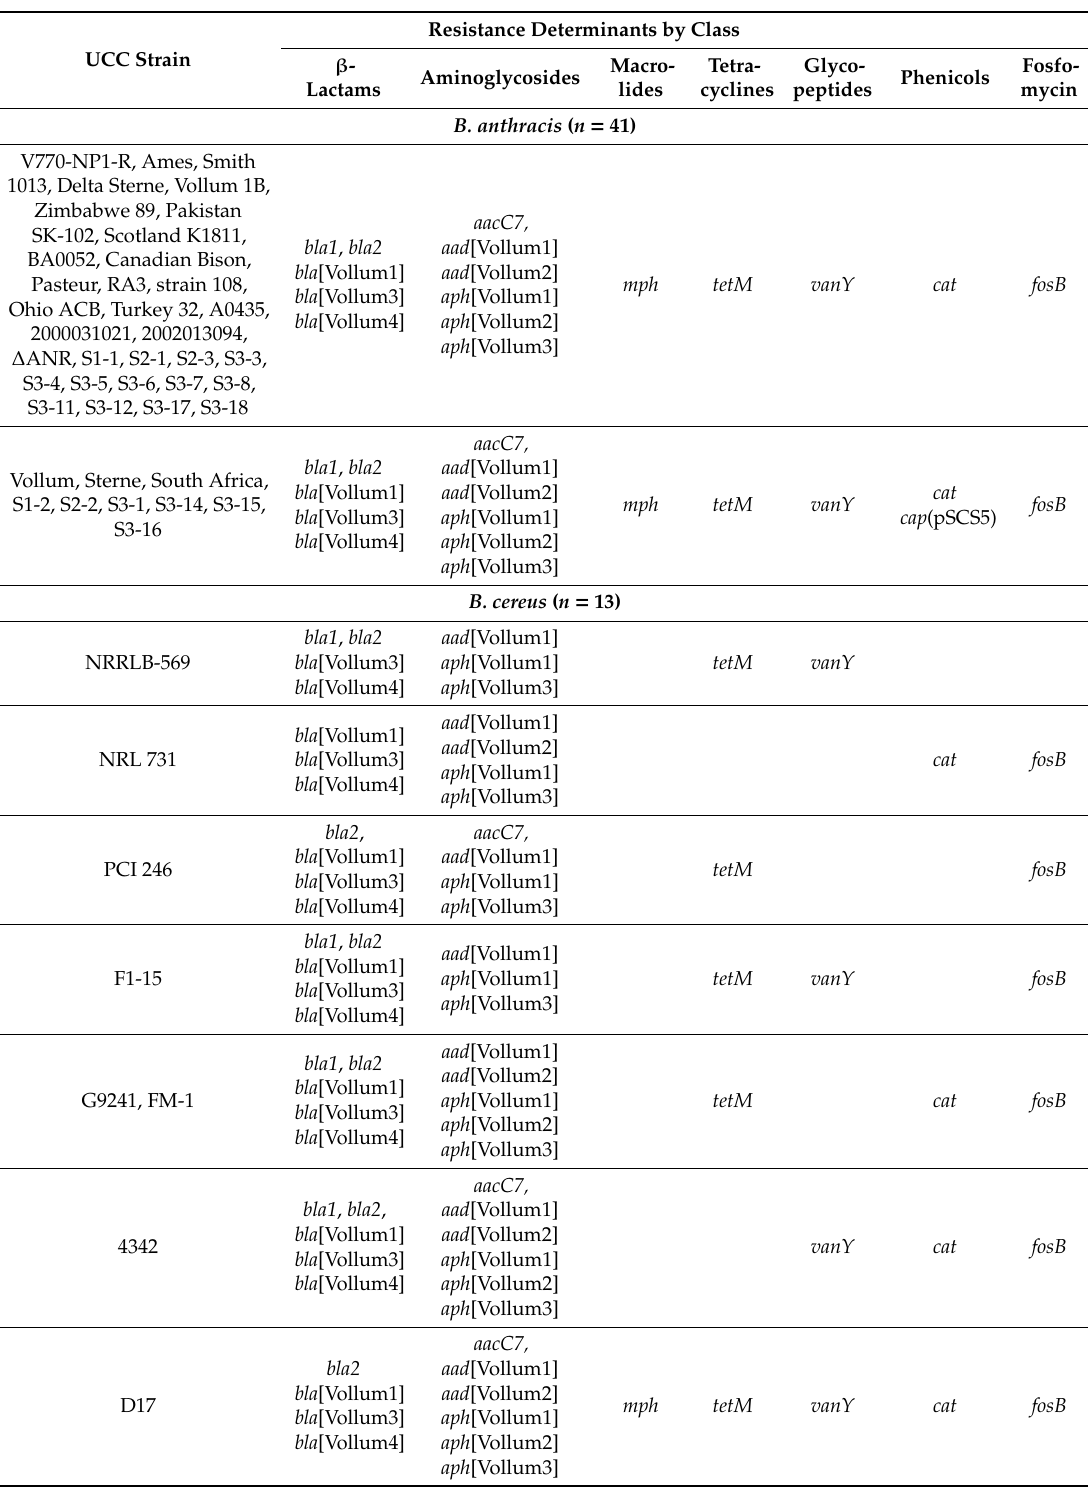
Table 4. Microarray-detected AMR genes in B. cereus group